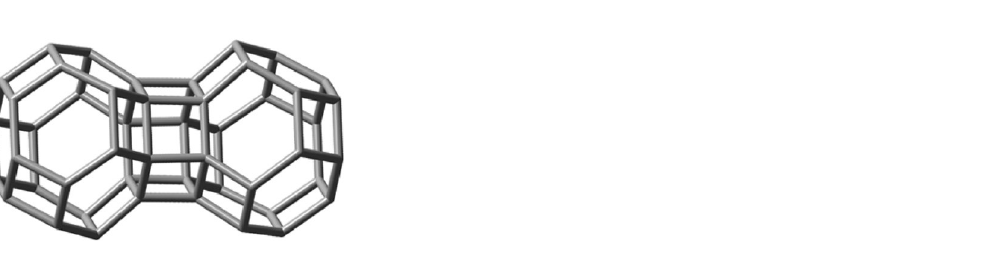
Figure 13. Compound C 48 H 42 obtained by fusing together two nugget 24a compounds via a hexagonal